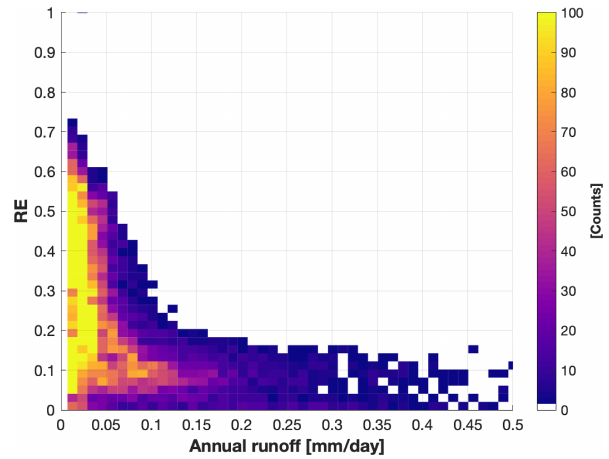
Figure 3. Plot of relative norm 2 error (RE) of surrogate models for the validation simulations vs. averaged annual runoff magnitude with all the grid cells from the arid